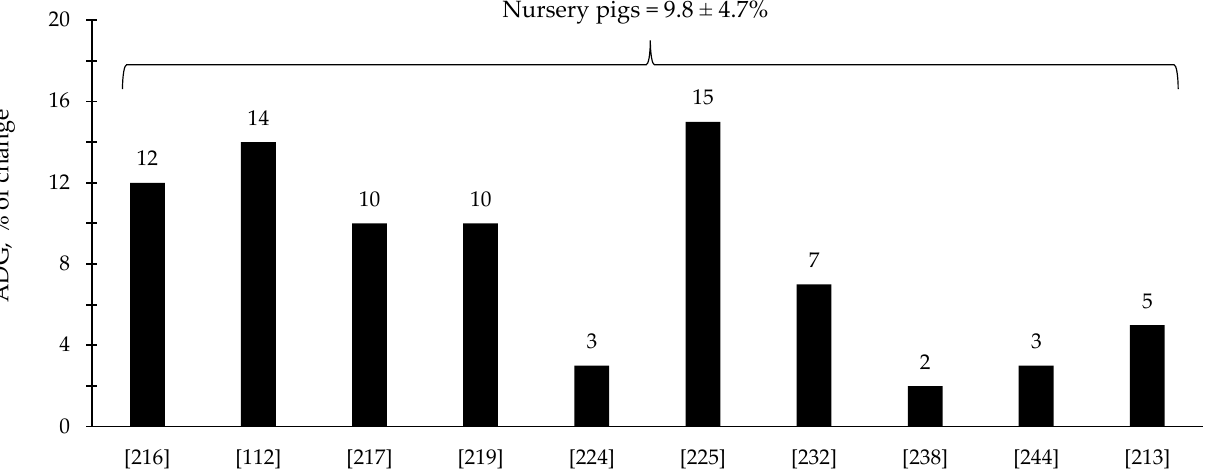
Figure 6. Changes in the average daily gain (ADG) of nursery pigs by xylanase supplementation among the studies displayed in Table 3 that showed changes in the ADG. The studies were selected from peer-reviewed literature available after 2000. The percentage of change refers to a statistically significant ( p < 0.05) and tendency (0.05 ≤ p < 0.10) effects of xylanase individually on the ADG reported from each respective study. The described effects were in comparison with treatments containing no xylanase. The average changes in the ADG of nursery pigs by xylanase supplementation were calculated excluding the studies that showed no effect.